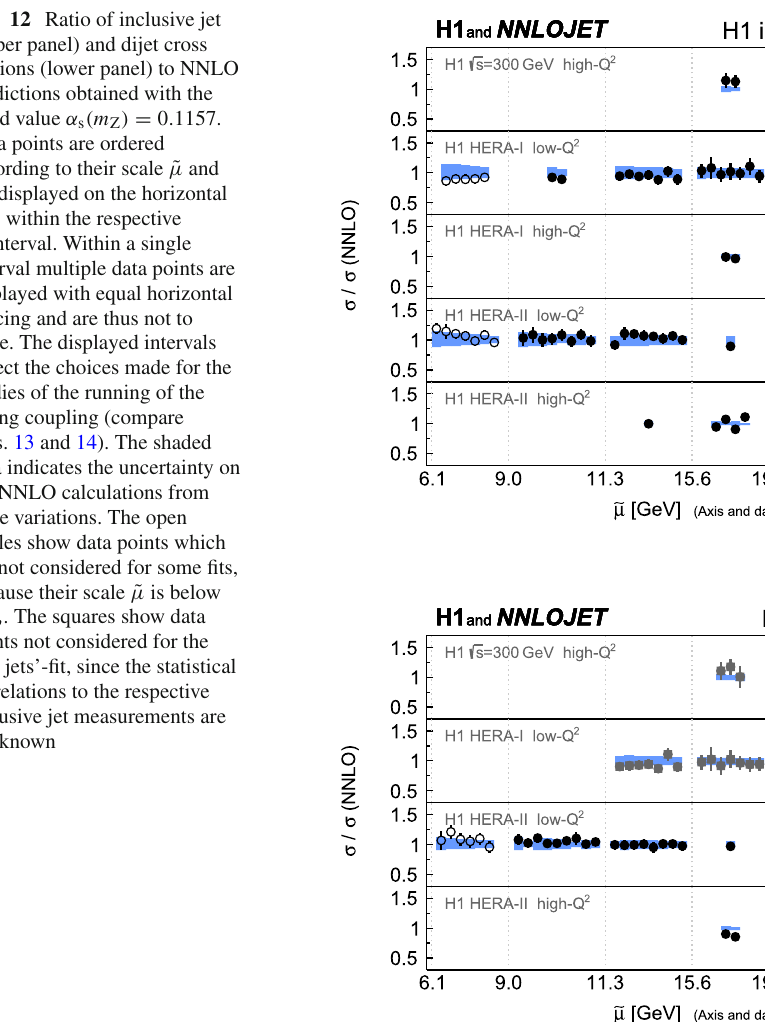
corresponds to the experimental (theory) uncertainty. The theory uncer- tainties include PDF related uncertainties and the dominating scale